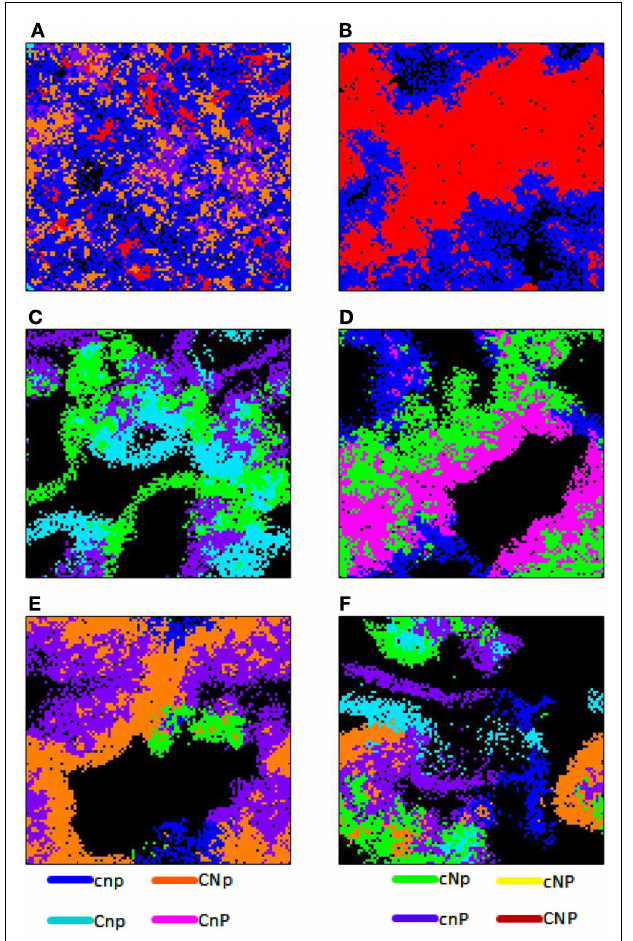
FIGURE 3 | Spatial grid at a time slice for various scenarios. In all figures, constitutive enzyme production is high (EConstit = 10 − 5 ). (A) Enzyme diffusion is intermediate (EDiff = 10 − 3 ), t = 34,000h. (B–D) Show different replicates with high enzyme diffusion (EDiff = 10 − 2 ). (B) Types CNP (red) and (cnp) blue, t = 20,000h. (C) Types CnP (pink), cNp (green), and cnp (blue), t = 21,000h. (D) Types Cnp (light blue), cNp (green), and cnP (purple), t = 25,000h. (E) Types CNp (orange), cNp (green), cnP (purple), and cnp (blue), t = 27,000h. (F) Types CNp (orange), Cnp (light blue), cNp (green), cnP (purple), and cnp (blue), t = 27,000h.